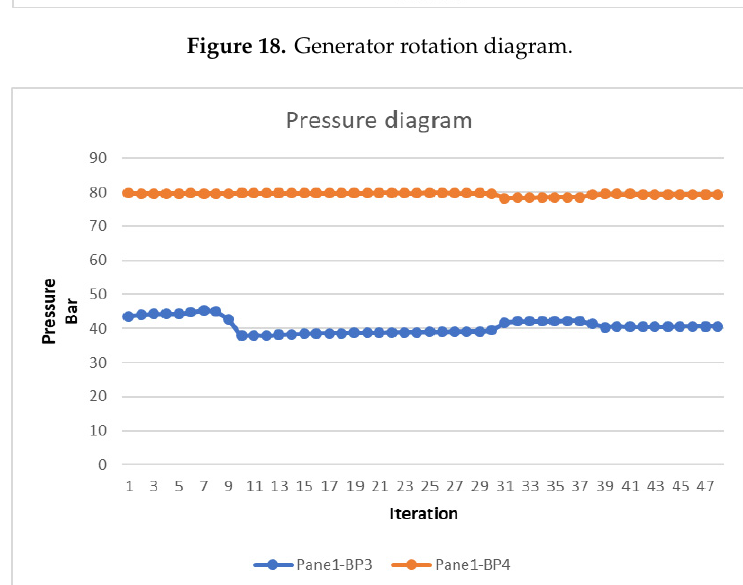
Figure 19. Helium Stirling engine and bottle pressure diagram.